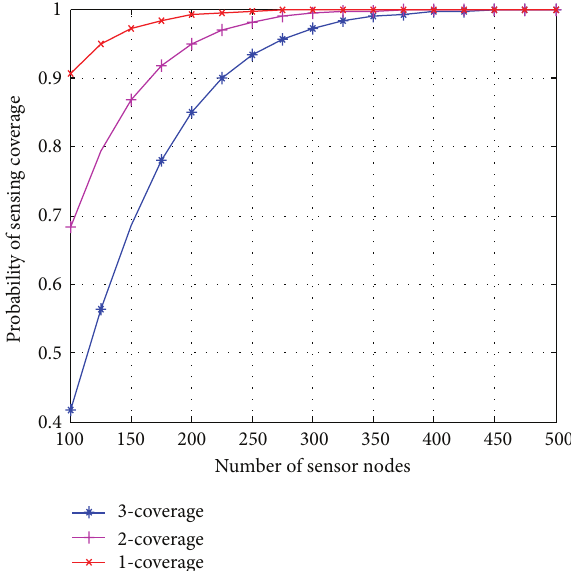
Figure 5: Probability of coverage versus number of sensor nodes for different failure